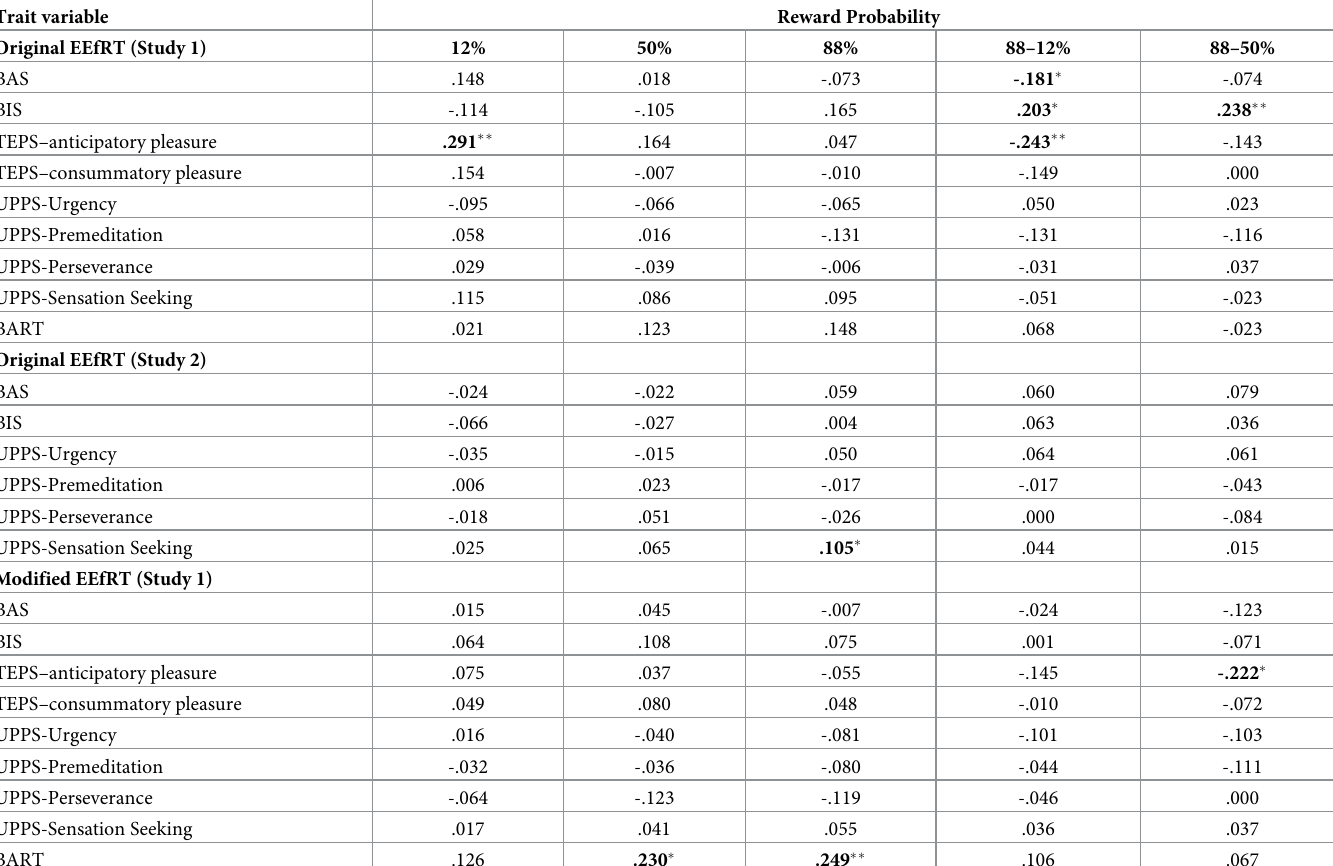
Table 5. Correlations between the original EEfRT (percentage of hard-task -choices), the modified EEfRT (mean number of clicks) and trait variables (Study 1 and